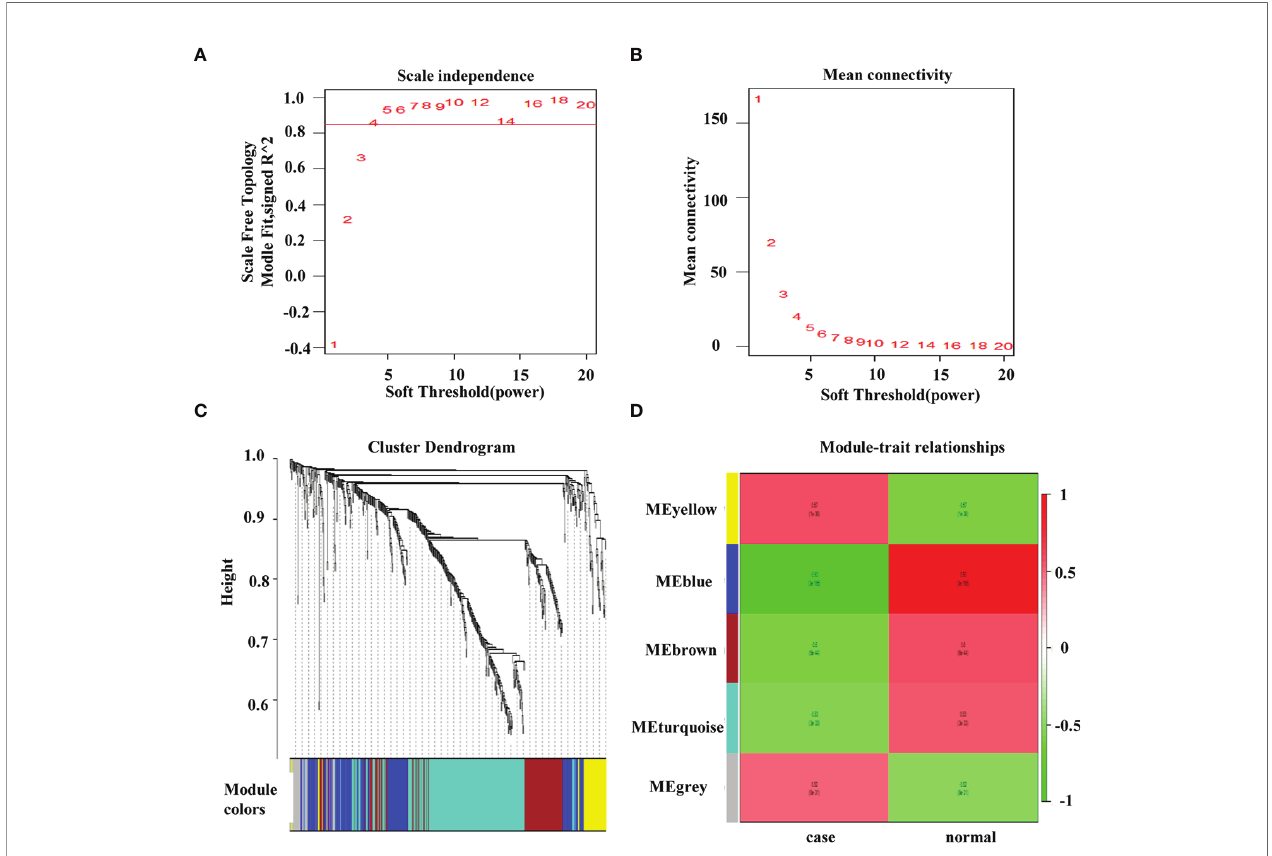
FIGURE 3 | Weighted colorectal cancer gene co-expression network. (A) T scale − free fi t index of various soft − thresholding powers. (B) Mean connectivity of various soft − thresholding powers. (C) A dendrogram of the differentially expressed genes clustered based on different metrics. (D) Heatmap of associations between module eigengenes and the progression of colorectal cancer. The association of the module and trait is calculated to be between − 1 and 1.